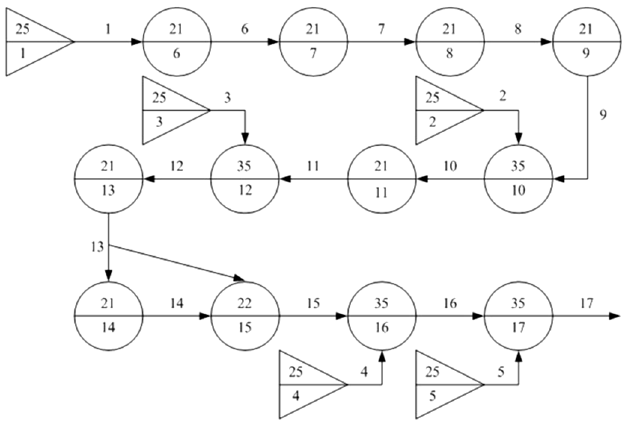
Fig. 3. The GO-FLOW diagram of the cross-regional mangos- teen cold chain logistics